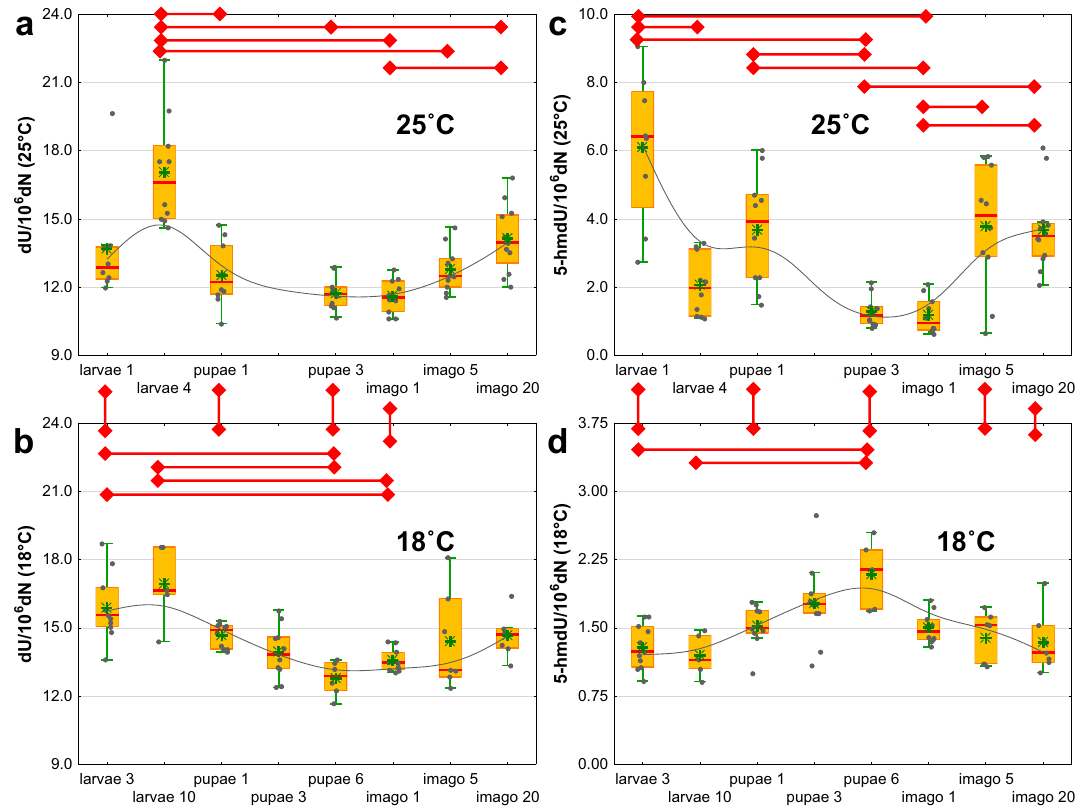
Figure 2. Changes in the levels of 2 ′ -deoxyuridine (dU) and 5-(hydroxymethyl)-2 ′ -deoxyuridine (5-hmdU) during the D. melanogaster life cycle ( a ) 2 ′ -deoxyuridine in insects bred in the optimal temperature conditions (25 °C), ( b ) 2 ′ -deoxyuridine in insects bred at 18 °C, ( c ) 5-(hydroxymethyl)-2 ′ -deoxyuridine in insects bred in optimal temperature conditions (25 °C), ( d ) 5-(hydroxymethyl)-2 ′ -deoxyuridine in insects bred at 18 °C. The results are presented as the mean and median values, interquartile ranges, and nonoutlier ranges ( p <